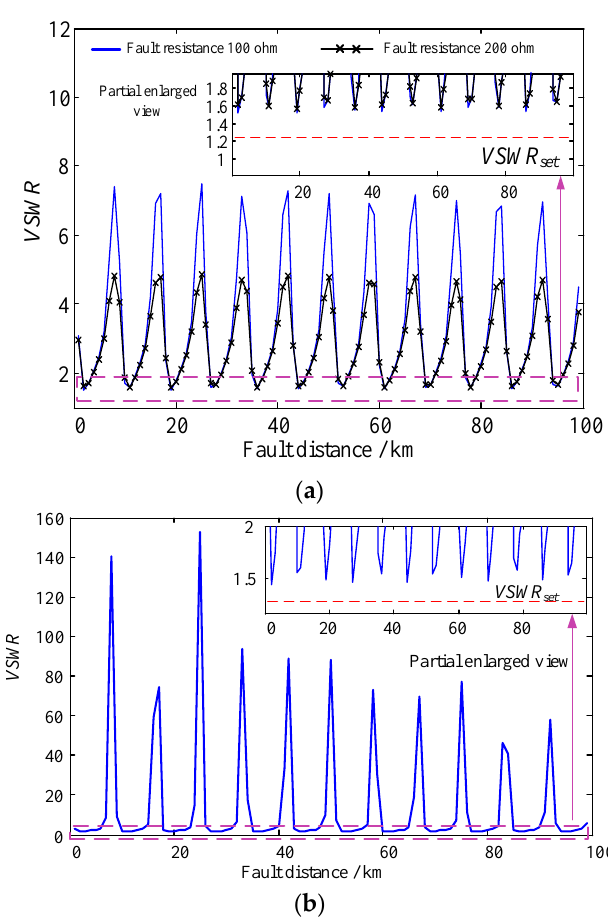
Figure 12. The VSWR for different fault position of single-line earth fault with mismatched terminal resistor. ( a ) the transition resistance are 100 Ω and 200 Ω, respectively; ( b ) the transition resistance is 0.1 Ω.